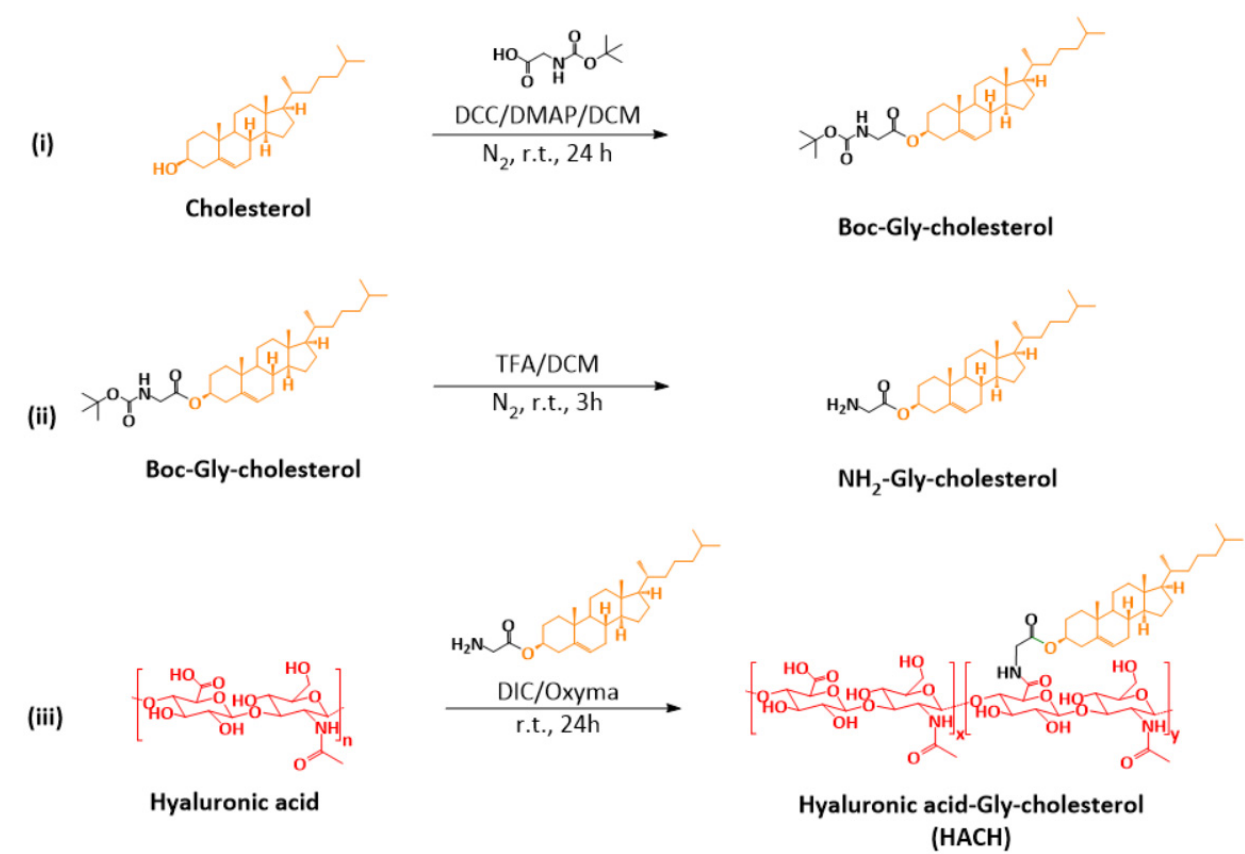
Figure 1. Synthetic pathway of HACH. In the first step, cholesterol was modified with Boc-Gly-OH by DCC/DMAP esterification. In the second step, the Boc group was removed under acidic conditions by TFA to produce NH 2 -Gly cholesterol. In the final step, NH 2 -Gly-cholesterol was conjugated to the carboxylic group of HA by DIC/Oxyma activation. ( i ) Modification of cholesterol; ( ii ) deprotection of Boc-Gly cholesterol; ( iii ) conjugation of Gly cholesterol on HA.